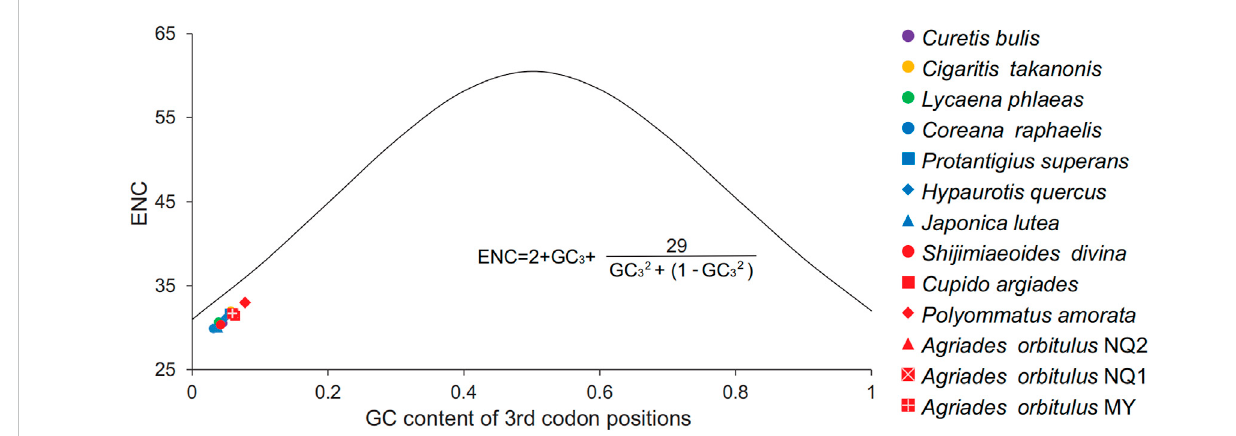
FIGURE 6 Correlation between the effective number of codons (ENC) and G + C content at the third codon position (GC 3 ) in the 13 protein-coding genes (PCGs) for Lycaenidae species. The solid line represents the relationship between the ENC and GC 3